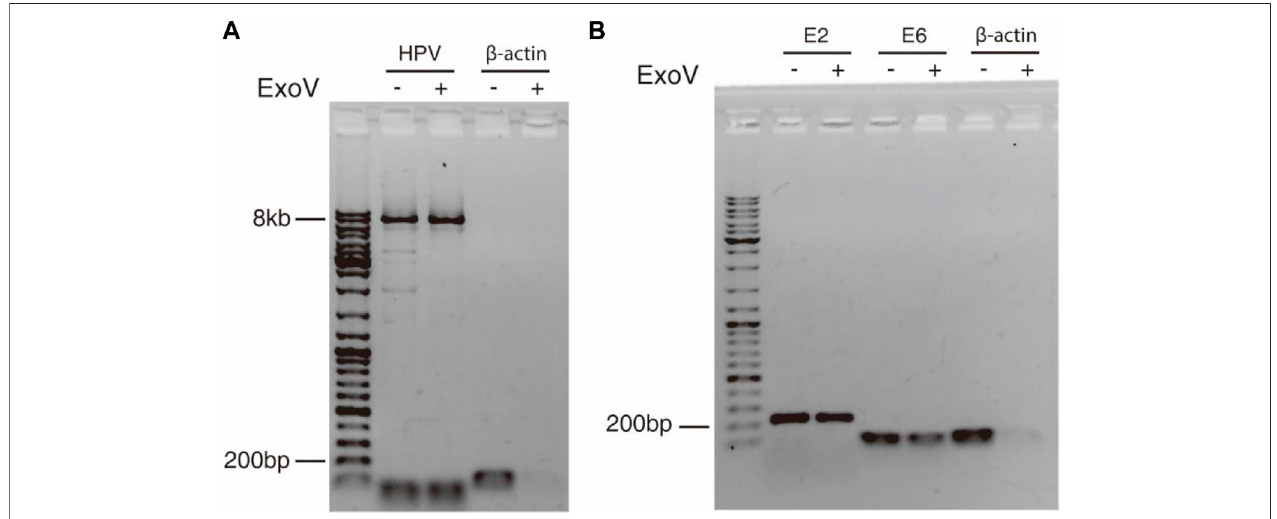
FIGURE 4 | Circular episomal HPV DNA was detected by exonuclease V digestion and PCR. (A) DNA extracted from cervical cancer tissue was digested with exonucleaseVandtheHPV genomewasampli fi edbylong-rangePCRusingapairofdivergent primers. (B) E2and E6wereampli fi edwithE2and E6primersfrom DNA treated with or without exonuclease V. β -actin served as a control.